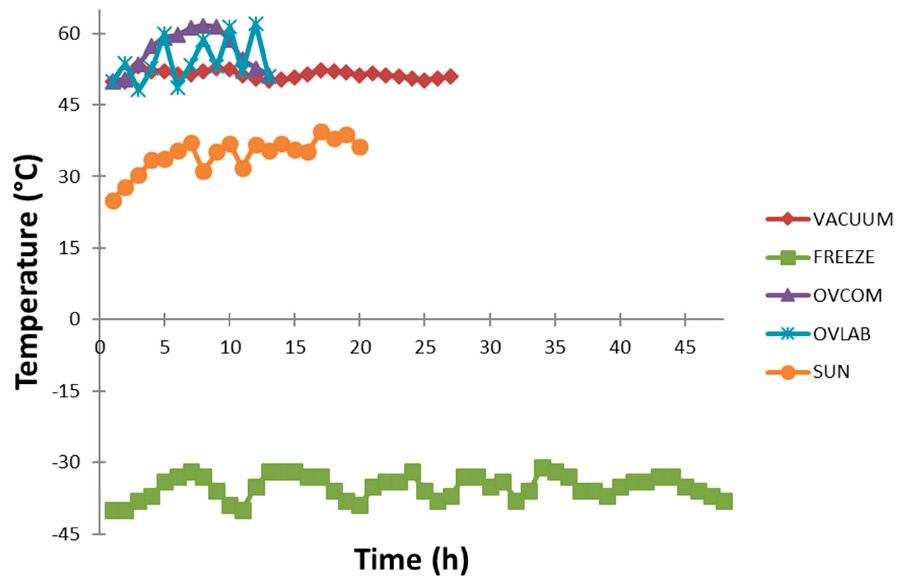
Figure 3. Drying temperature and time of the different methods applied.